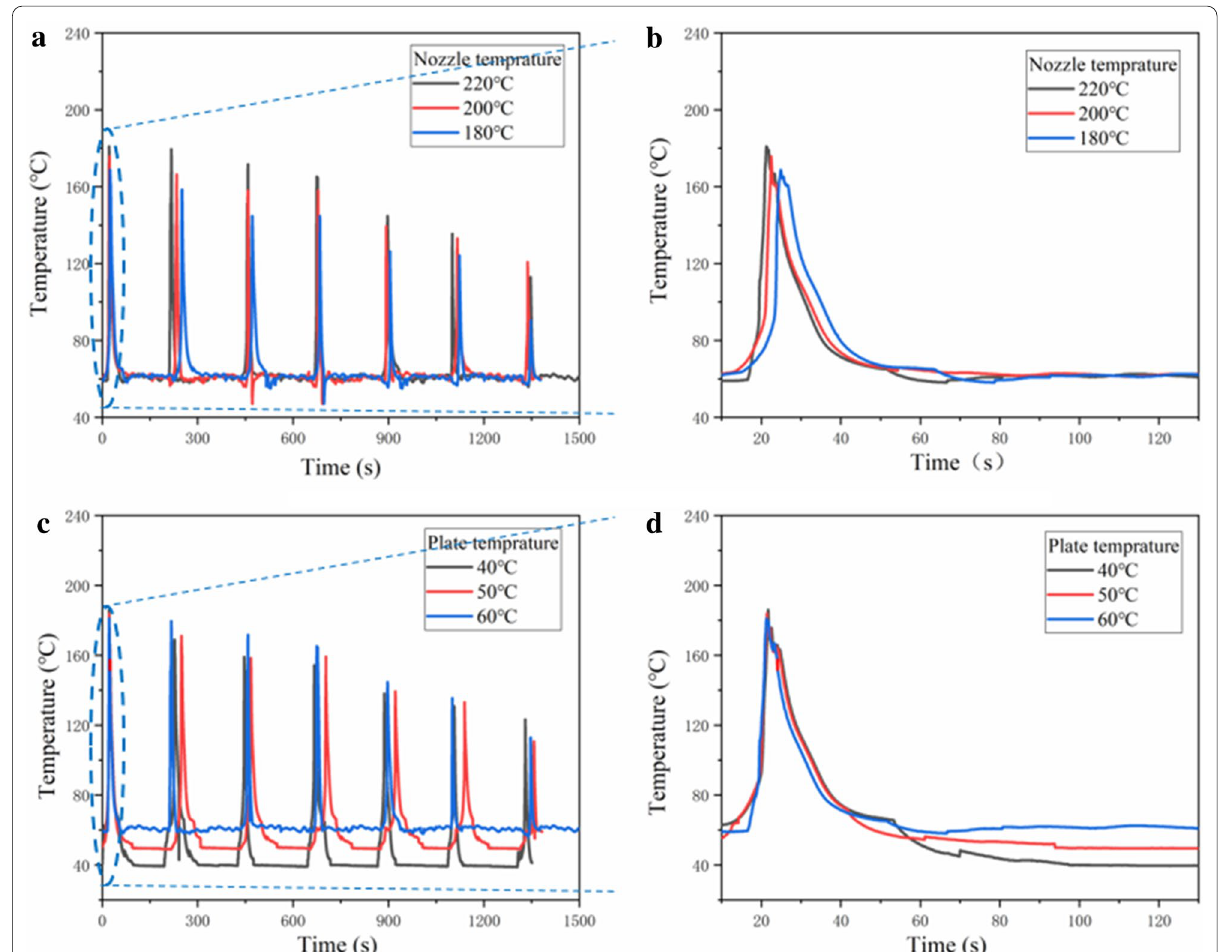
Figure 3 Results of temperature monitored under different nozzle and basement temperatures, where the basement temperature in a and b is 60 °C, nozzle temperature in c and d is 220 °C, and b and d are the enlarged